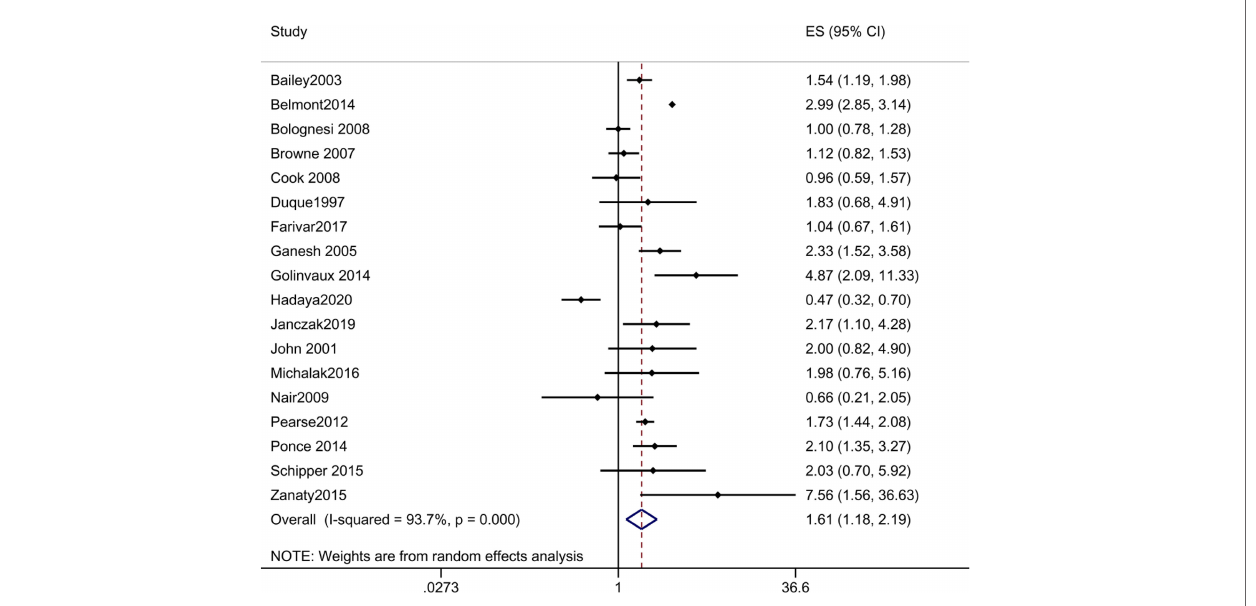
FIGURE 3 | Forest plot of odds ratio of postoperative mortality in patients with DM vs those without